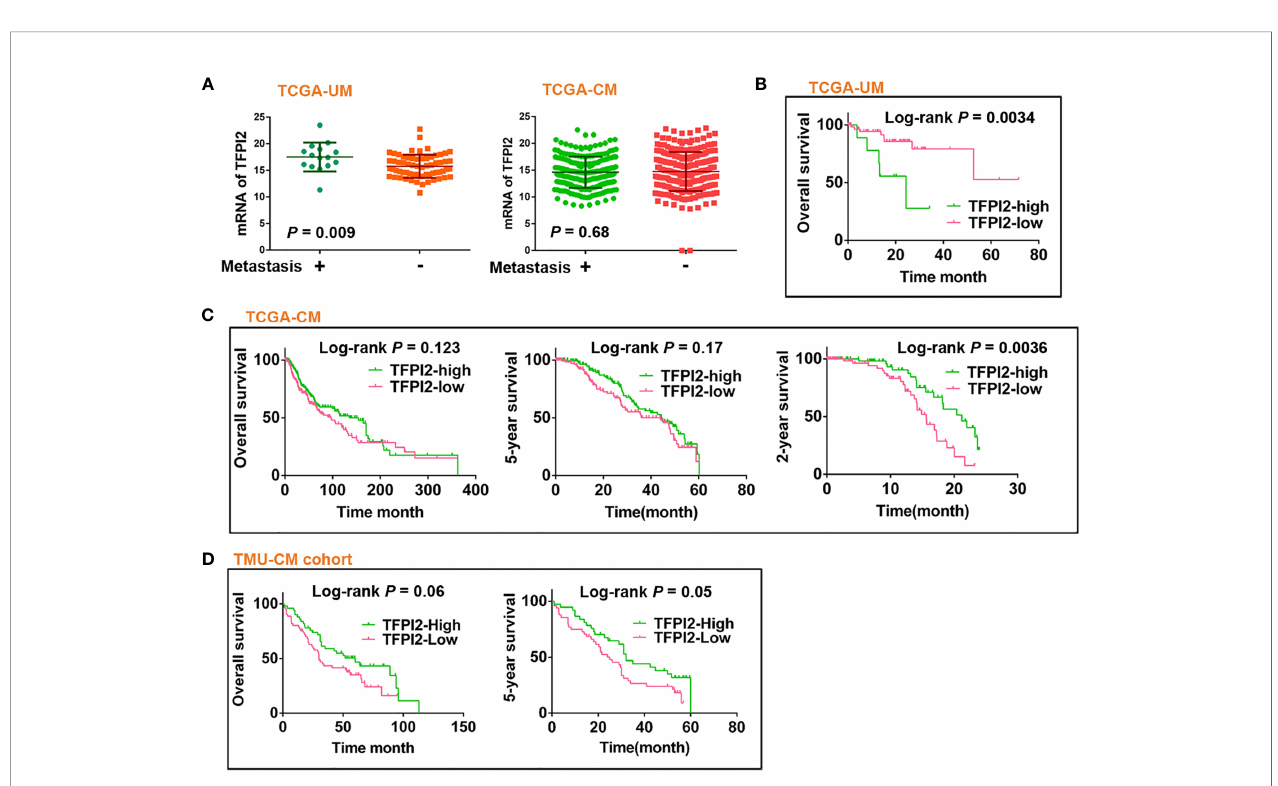
FIGURE 6 | Prognostic signi fi cance of TFPI2 in melanoma patients. (A) Dot plot represents mRNA levels of TFPI2 in metastasis (+) vs. mestastasis ( − ) groups of TCGA-UM and TCGA-CM data, respectively. (B – D) Kaplan – Meier estimates of survival time for TCGA-UM, TCGA-CM, and TMU-CM cohort patients who were strati fi ed into two groups: high and low levels of